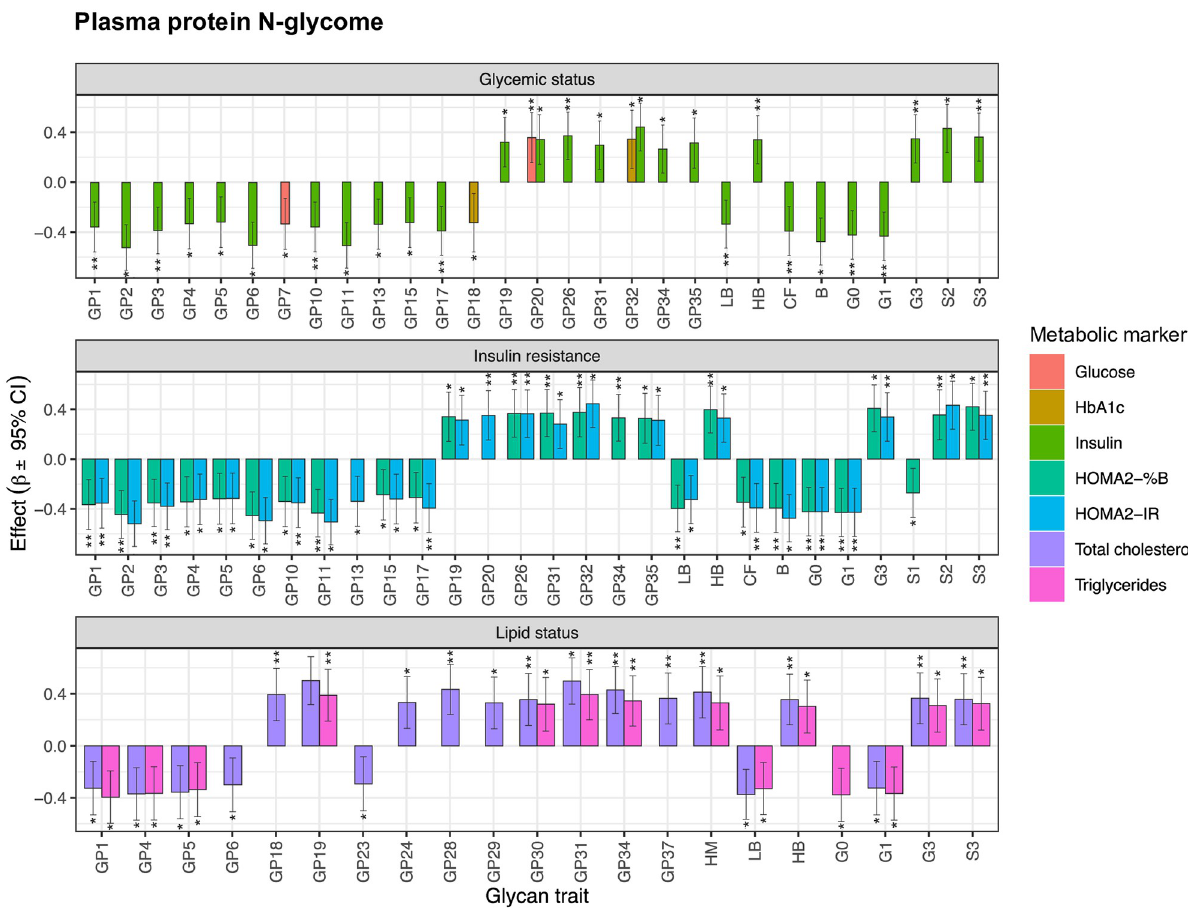
Fig 2. Significant associations of plasma protein N-glycan traits with metabolic parameters in pregnancy. Effect size represents beta coefficient estimated through regression model. Error bars represent 95% confidence intervals. B—bisecting GlcNAc; CF—core fucosylation; GP—glycan peak; G0 –agalactosylation; G1 –monogalactosylation; G3 –trigalactosylation; HB—high branching; HM—high mannose; LB—low branching; S0 – asialylation; S1 –monosialylation; S2 –disialylation; S3 –trisialylation;; * –adjusted p-value in range 0.05–0.01; ** –adjusted p-value in range 0.01–0.001; *** –adjusted p-value <